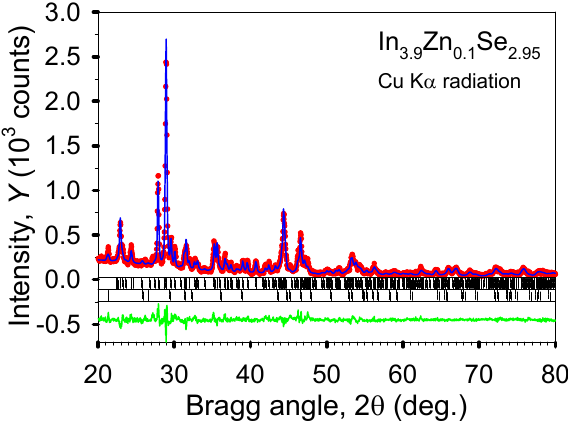
Figure 10. The observed (dots) and calculated (line) powder diffraction patterns of polycrystalline In 3.9 Zn 0.1 Se 2.95 after the completion of Rietveld refinements. The upper sets of vertical bars located just below the plots of the observed and calculated intensities indicate the calculated positions of the Bragg peaks of the majority 4:3 In–Se phase, while the lower sets of bars correspond to the calculated positions of the Bragg peaks of the 1:1 In–Se impurity. The difference, Y obs – Y calc , is shown at the bottom of the